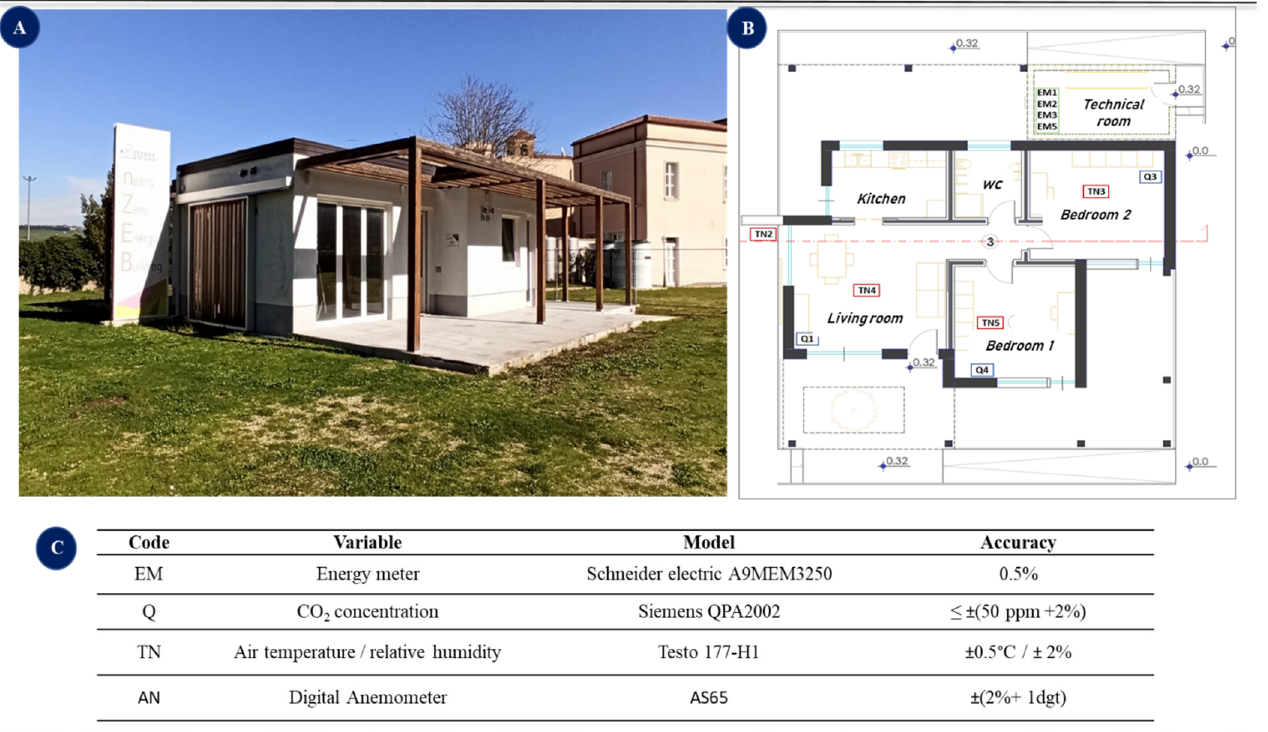
Figure 1. BNZEB: ( A ) external view, ( B ) layout, and ( C ) accuracy of main sensors.